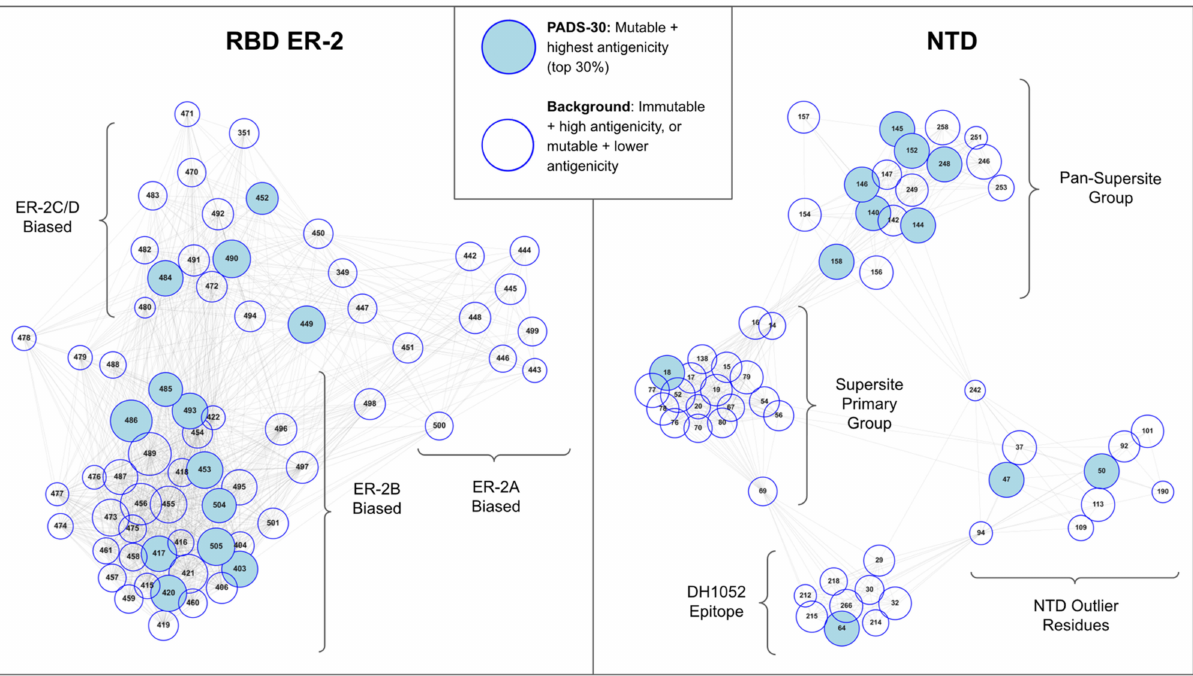
Figure 2. Map of RBD ER-2 and NTD Antigenic Space. RBD or NTD residues are represented as nodes with node size proportional to estimated antigenicity and node color representative of mutability and antigenicity ranking (PADS-30 designation). Node positions and edges are determined based on cosine similarity between sites in the